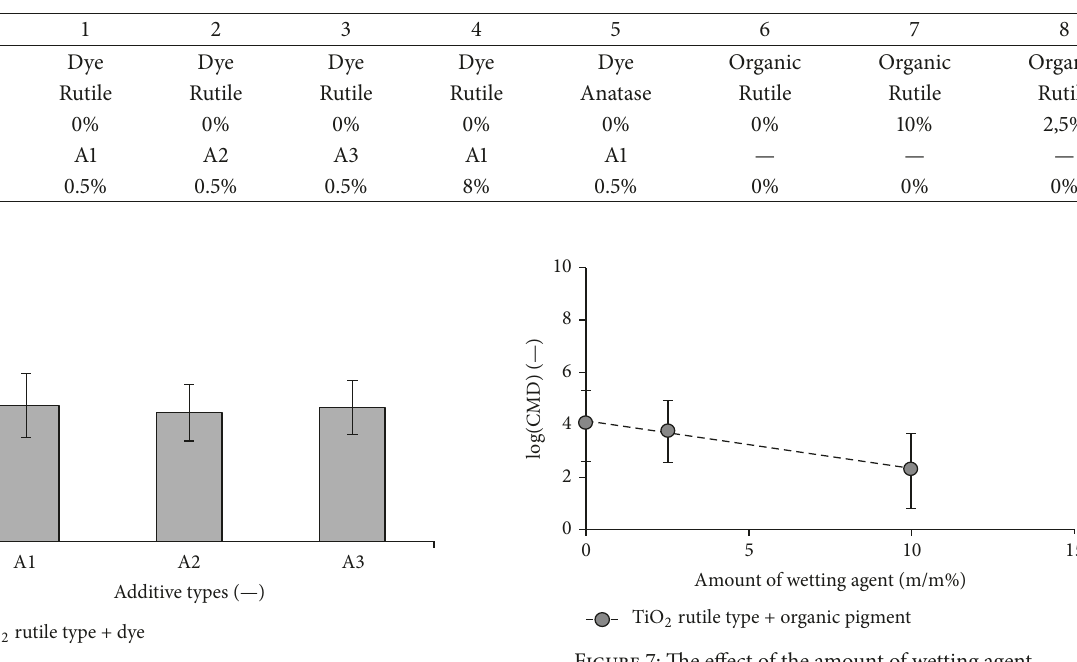
Figure 5: The effect of the different additives.